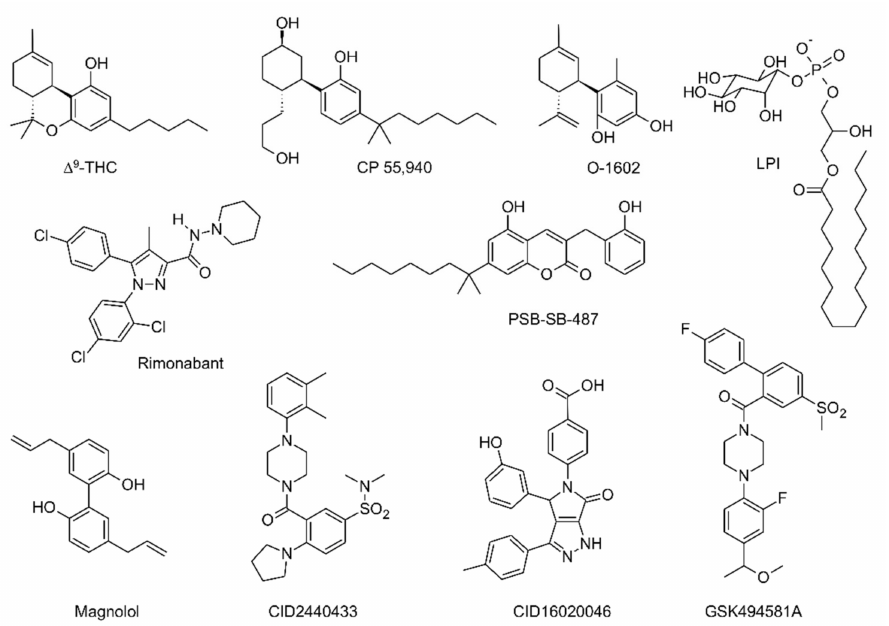
Figure 2. Chemical structures of representative GPR55 ligands.